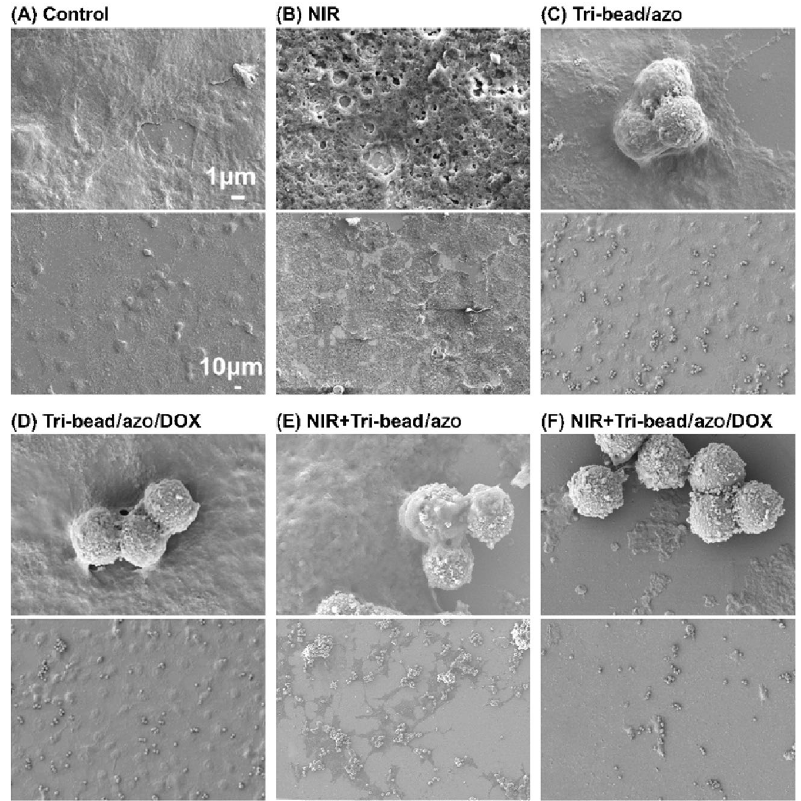
Figure 4. SEM images of H1299 cells incubated at different conditions: ( A ) control, ( B ) NIR irradiation, ( C ) tri-bead/azo microrobots, ( D ) tri-bead/azo/DOX, ( E ) tri-bead/azo with NIR irradiation for 24 h, and ( F ) tri-bead/azo/DOX with NIR irradiation for 24 h. The top and bottom images are zoomed-in and zoomed-out regions